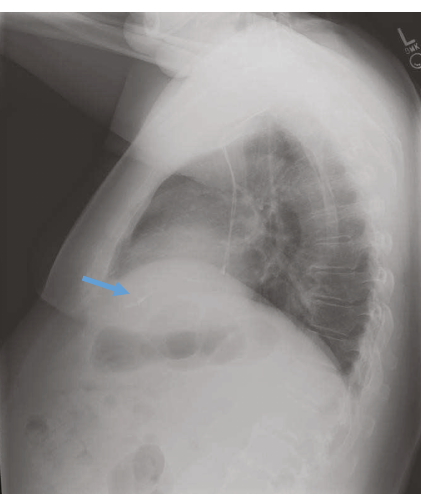
Figure 4: Lateral chest X-ray showed right atrial lead fracture (blue